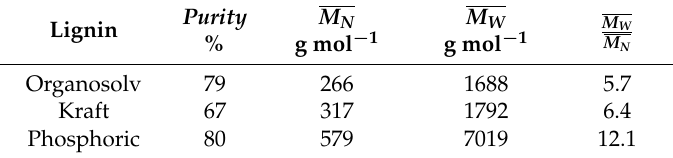
Table 1. Purity of lignin (Klason lignin) and parameters obtained from size exclusion chromatography (SEC).